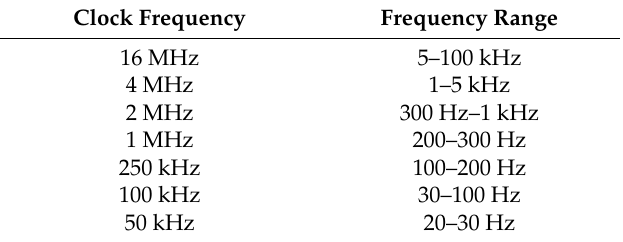
Table 1. External clock frequencies required to achieve a specific frequency range [25].